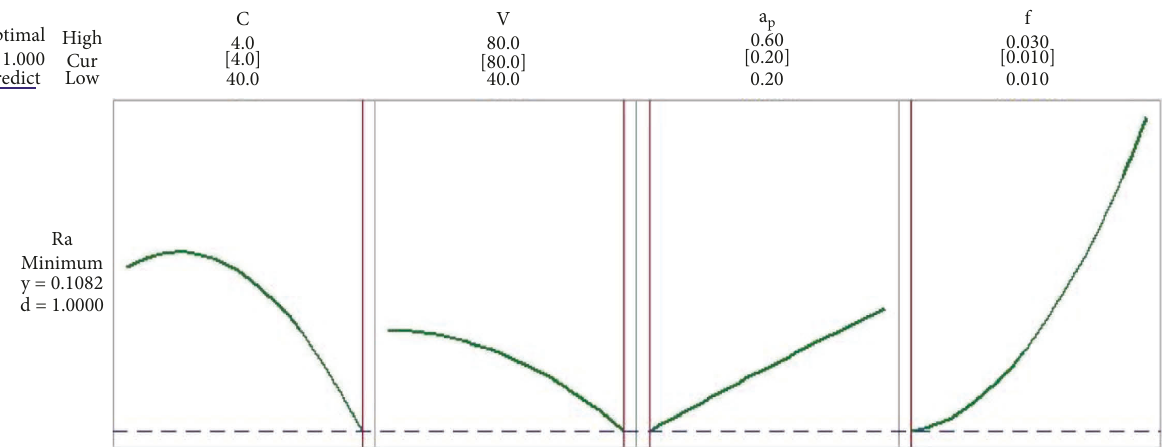
Figure 3: The optimal plot of surface roughness.